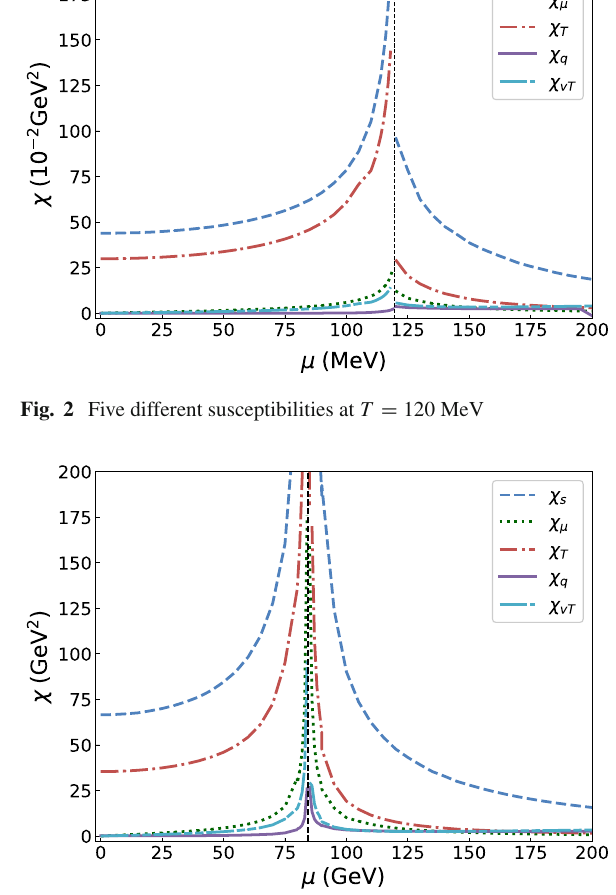
Fig. 3 Five different susceptibilities at T = 129